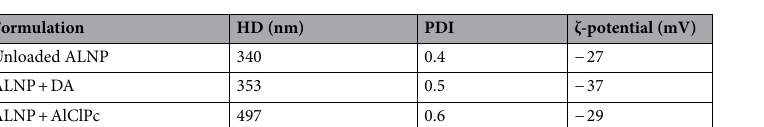
Table 1. Physicochemical nanoparticle characterization. Physicochemical parameters observed in the different sub-variations of albumin/PLGA nanosystems tested, as determined by dynamic light scattering. Values were determined as the mean of three runs (10 measurements/run). ALNP albumin/PLGA nanosystems, AlClPc aluminum chloride phthalocyanine, DA dopamine, HD hydrodynamic diameter, PDI polydispersity index, ζ-potential zeta potential.